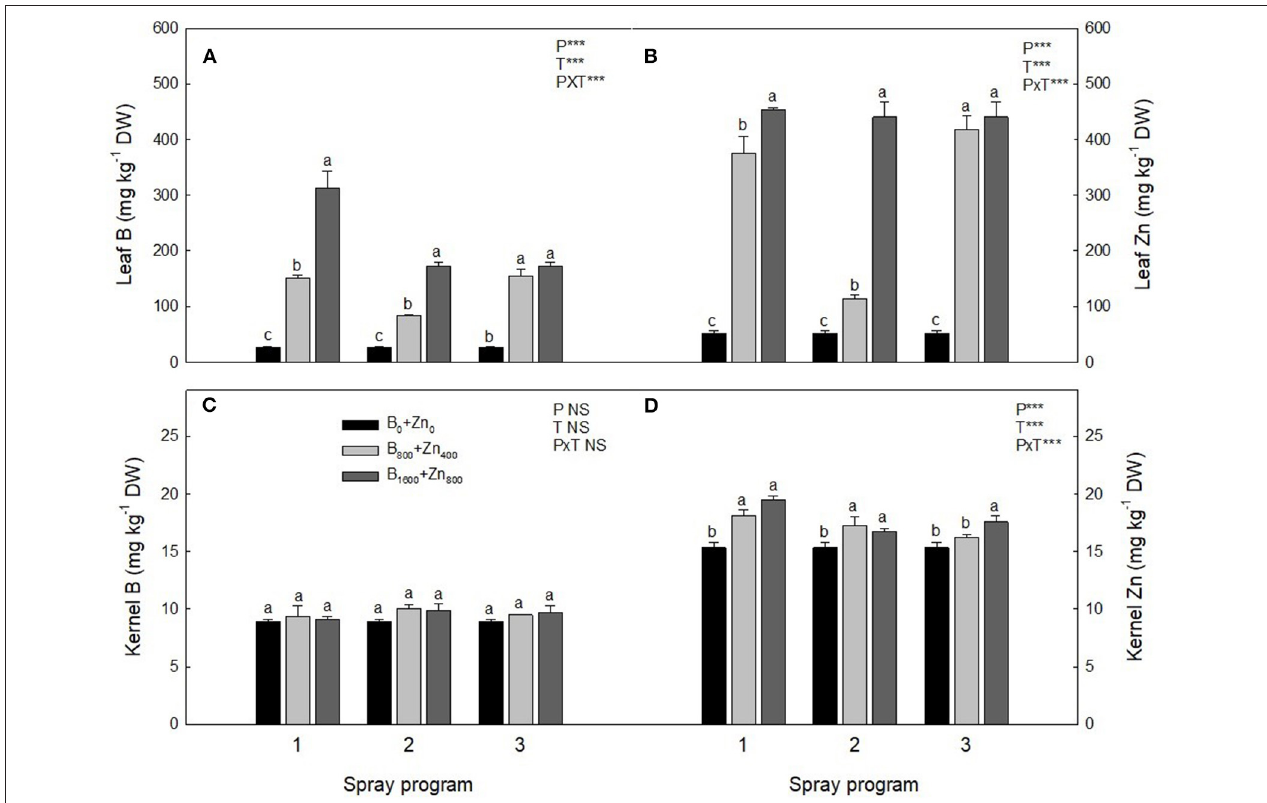
FIGURE 2 | B and Zn concentration (mg kg − 1 DW) in leaves (A,B) and kernels (C,D) of hazelnut trees depending on the applied spraying program. Values represent the mean ( n = 3) ± SE. Different lowercase letters indicate statistically significant differences ( P ≤ 0.05) among treatments within each spray program. Two-way ANOVA results are shown (NS, not significant, P > 0.05; *** P <